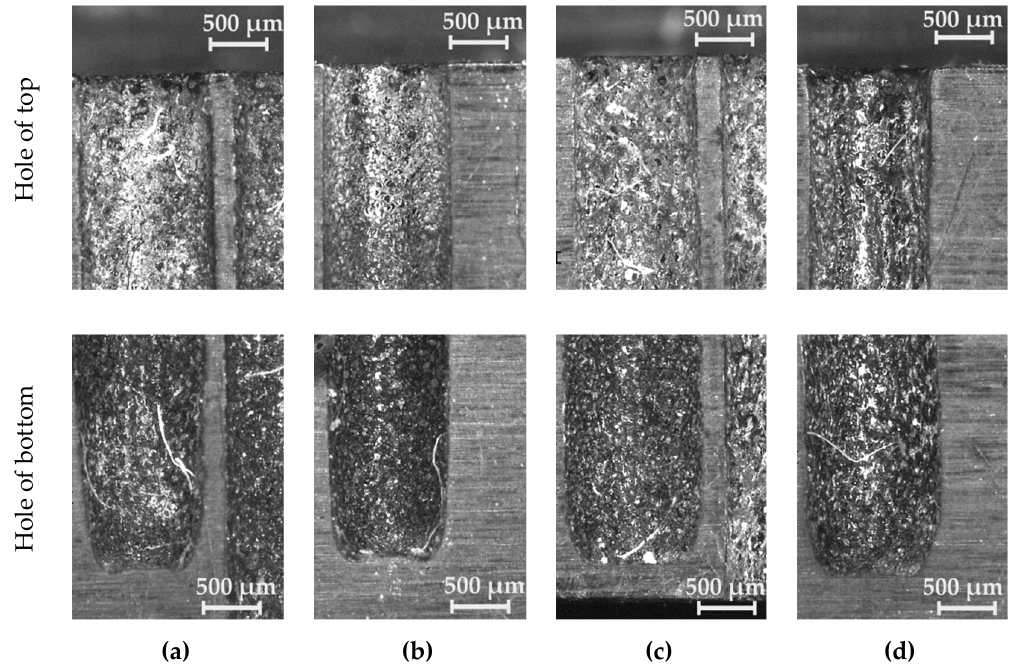
Figure 13. Images of the internal surface of the hole for the machining parameters. ( a ) U = 80 V, t i = 818 µ s, I = 3.33 A, and AR = 6; ( b ) U = 100 V, t i = 100 µ s, I = 3.83 A, and AR = 10; ( c ) U = 100 V, t i = 818 μs, I = 3.33 A, and AR = 6; ( b ) U = 100 V, t i = 100 μs, I = 3.83 A, and AR = 10; ( c ) U = 100 V, t i = 282 282 µ s, I = 4.32 A, and AR = 23; ( d ) U = 100 V, t i = 550 µ s, I = 3.83 A, and AR = 12. μs, I = 4.32 A, and AR = 23; ( d ) U = 100 V, t i = 550 μs, I = 3.83 A, and AR = 12.